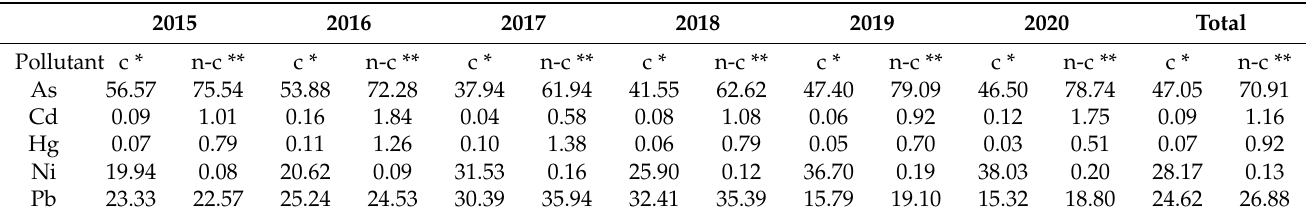
Table 5. The contribution of heavy metals to the total impact scores.